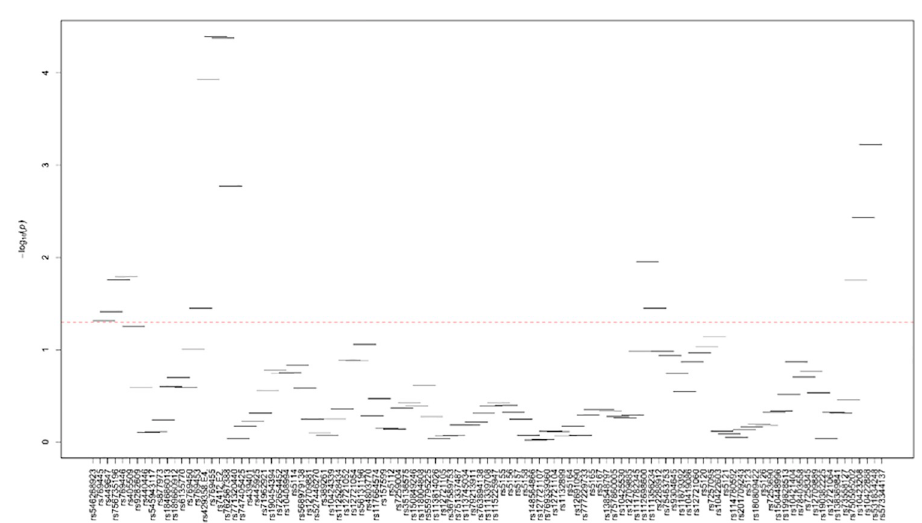
Fig 11. Plots of haplotype-based association analysis results for TC in African blacks. Horizontal lines represent the 4-SNP windows. X-axis shows the SNPs genotyped in the regions based on the order of APOE , APOC1 , HCR1 , HCR2 , APOC4 and APOC2 while the Y-axis shows the–log (global p-value) with red line representing the p-value threshold (P = 0.05).